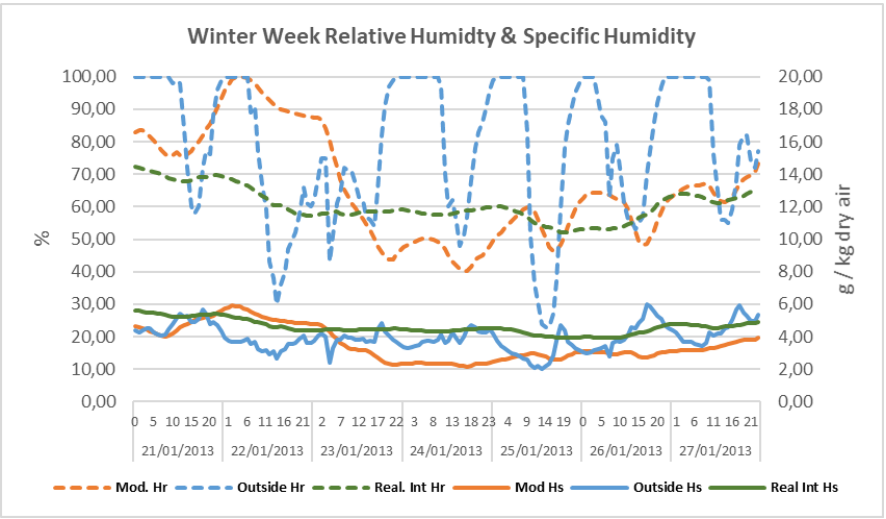
Figure 25. Hourly outdoor temperatures, real and modeled indoor temperatures, and outdoor and real indoor relative humidity (winter).